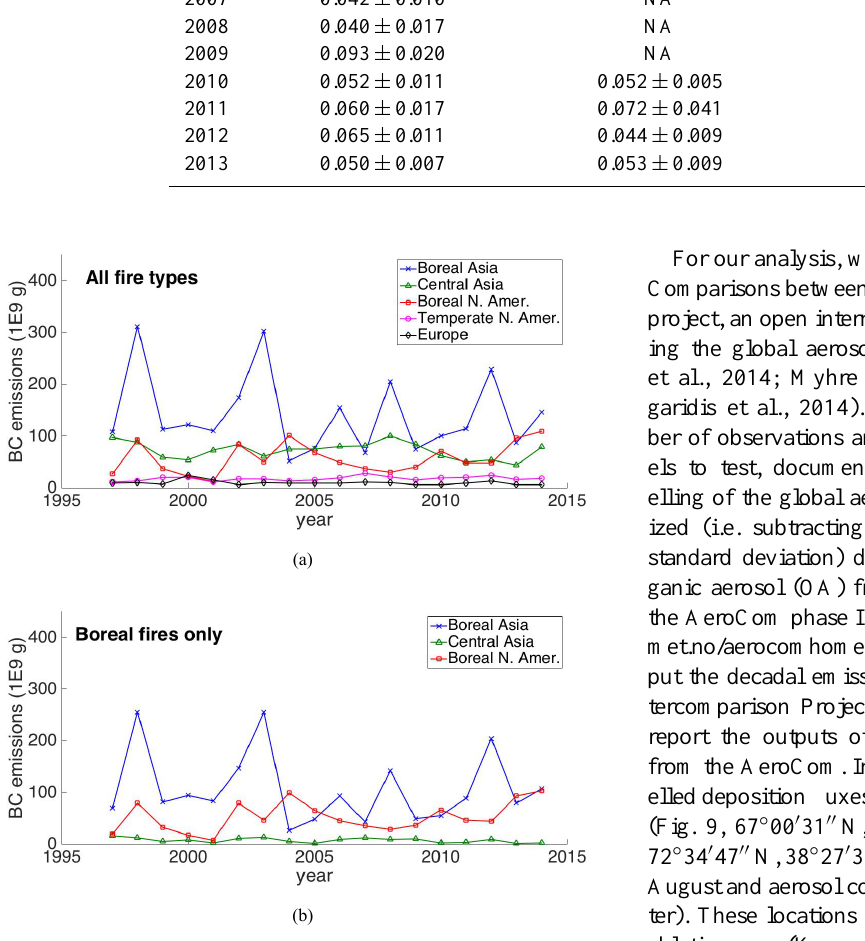
Figure 8 Figure 8. BC emissions (g) from fires in potential source regions for GrIS for (a) all fire types and (b) boreal fires only using estimates from the Global Fire Emissions Database (GFED version 4.1, http: //www.globalfiredata.org/) between 1997 and